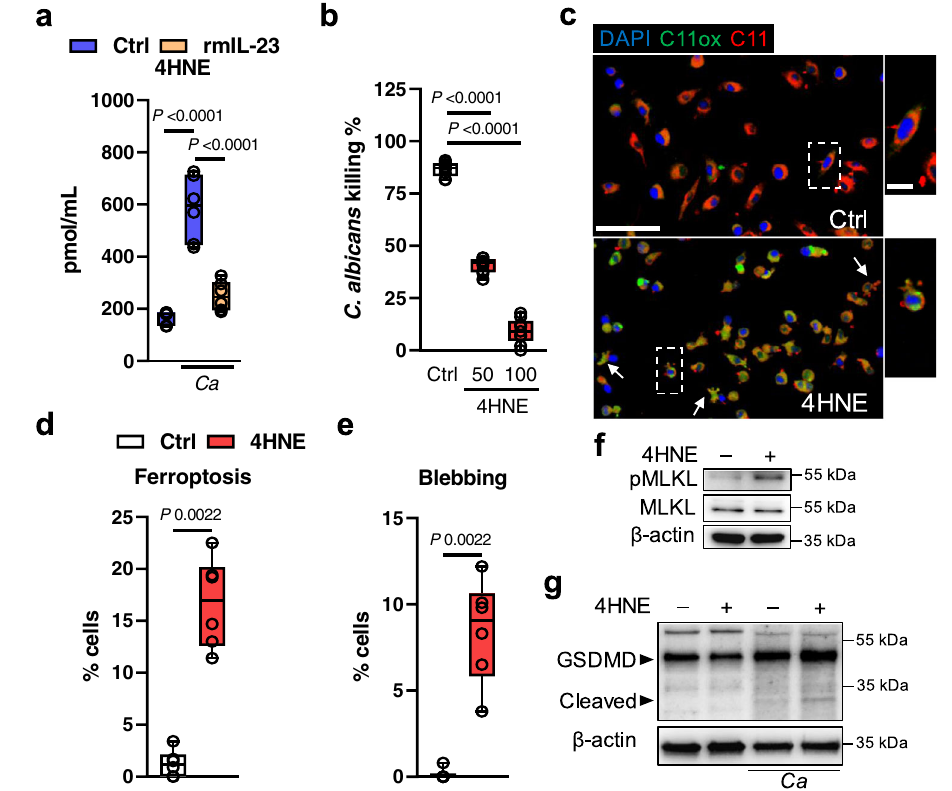
Fig. 10 | Exogenous 4HNE inhibits macrophage-mediated killing and induces host cell death. a 4HNE release of BMDMs during C. albicans infection. Twelve hours post infection. N =3 in duplicate. Two-tailed Mann – Whitney Test. Box-and- whisker plots indicating median, 25th/75th percentiles, and the minimum/max- imumvalues. b Macrophage-mediatedkillingofcellsincubatedwith4HNE.MOI1:5. 12h post infection. N =3 in triplicate. Ordinary one-way ANOVA corrected for multiple comparison. Box-and-whisker plots indicating median, 25th/75th percen- tiles,andtheminimum/maximumvalues. c RepresentativeimagesofC11oxidation of BM-derived macrophages incubated for 4h with 50 μ M 4HNE. Blebbing (apop- totic cells) indicated with arrows. Scale bar 50 (left) and 10 μ m (right). Dotted